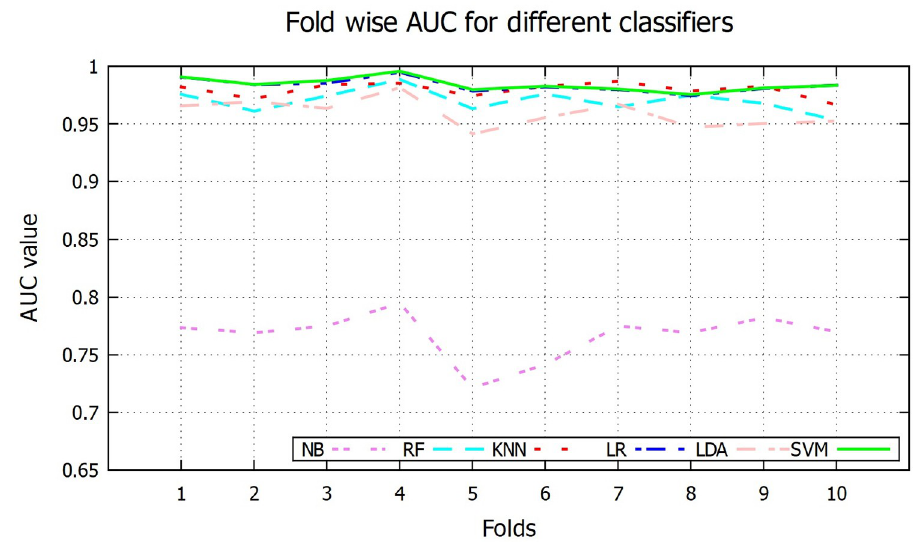
Fig 11. Fold wise AUC value.